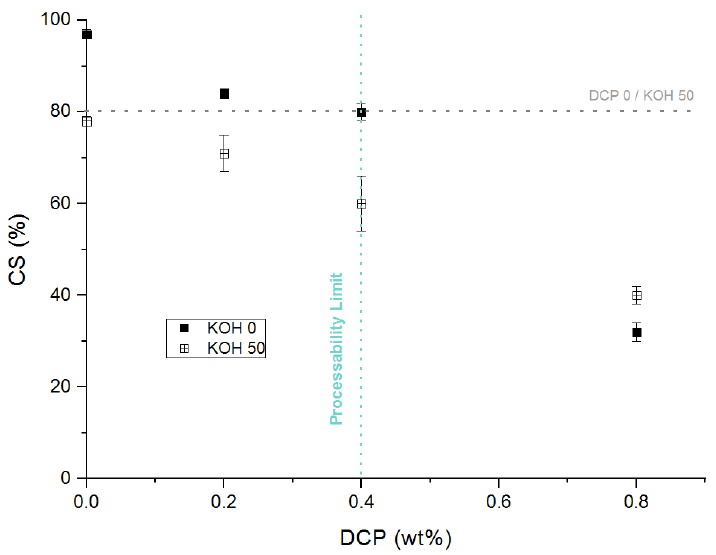
Figure 7. Variation of the compression set versus DPC concentration. Influence of the combination of both ionic and covalent networks.